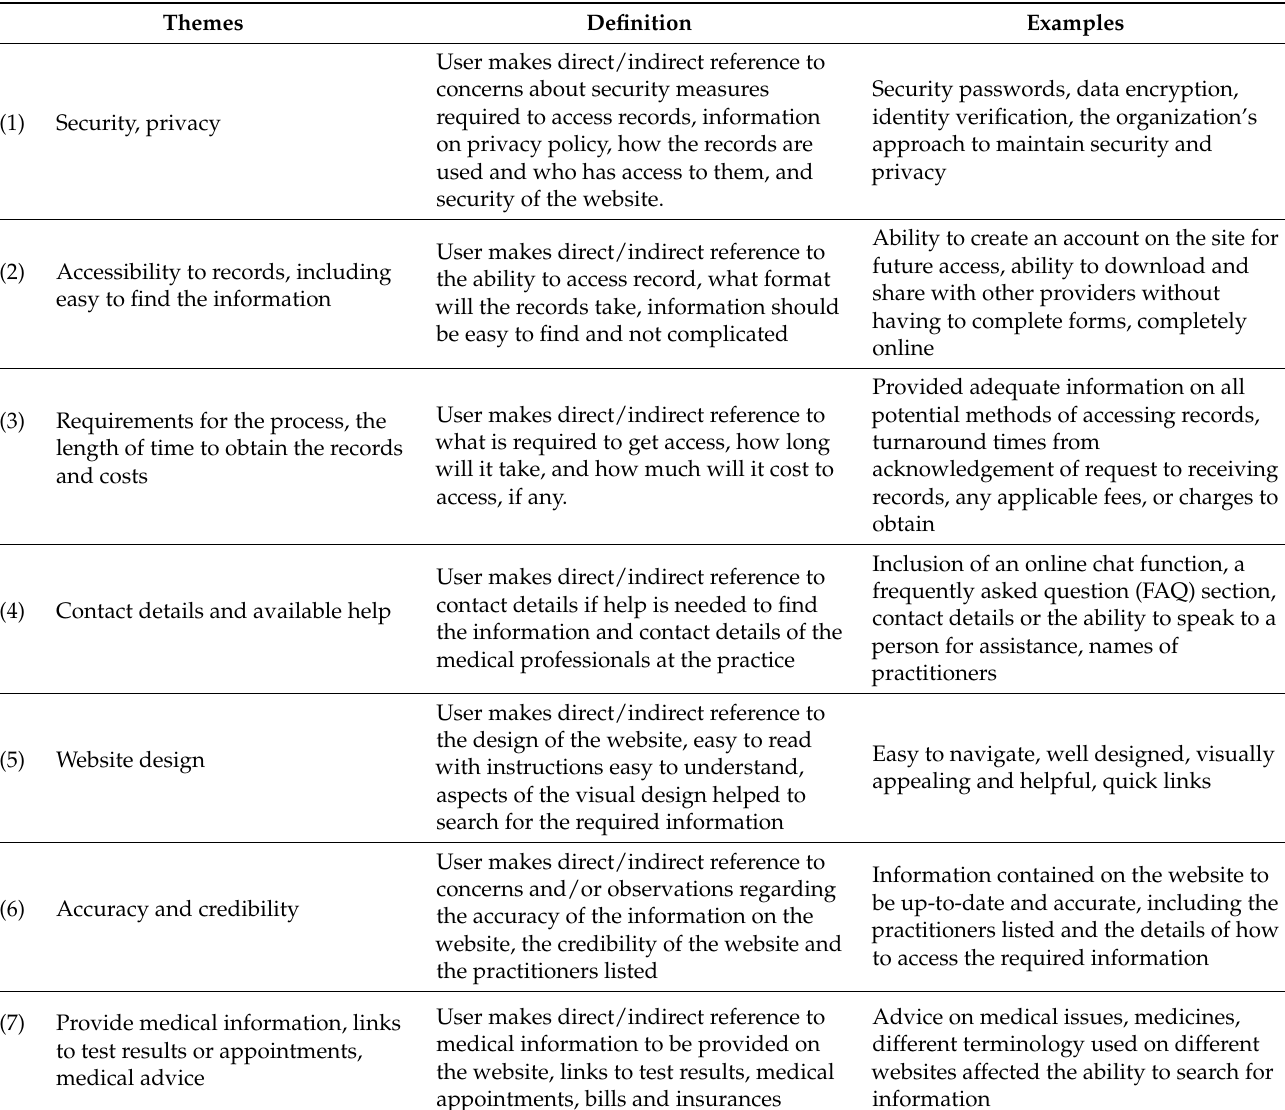
Table 2. Thematic analysis: first round coding rules and